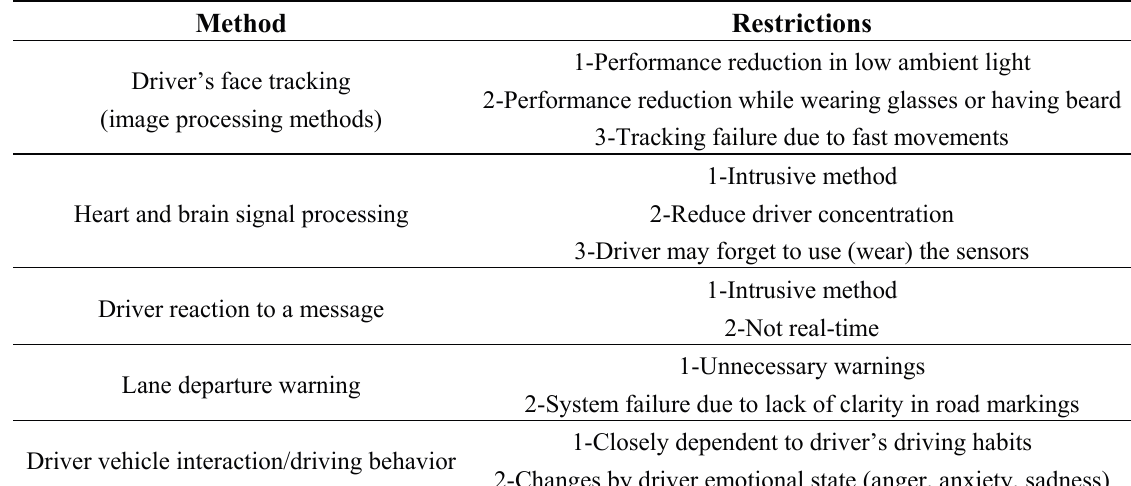
Table 1 . List of the different drowsiness detection methods and their possible cause of